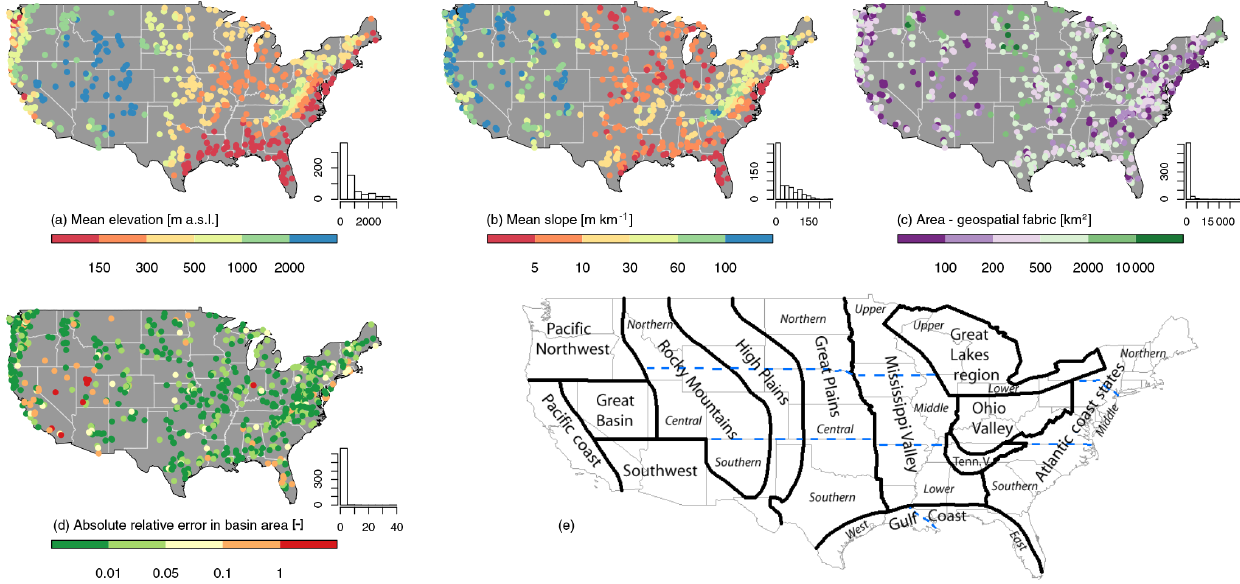
Figure 1. (a–d) Maps of topographic characteristics over the CONUS. The histograms indicate the number of catchments (out of 671) in each bin. (e) Map of the regions referred to in this study (source: NOAA National Centers for Environmental Information; https://www.ncdc. noaa.gov/temp-and-precip/drought/nadm/geography). Table 1. Name, location, and topographic